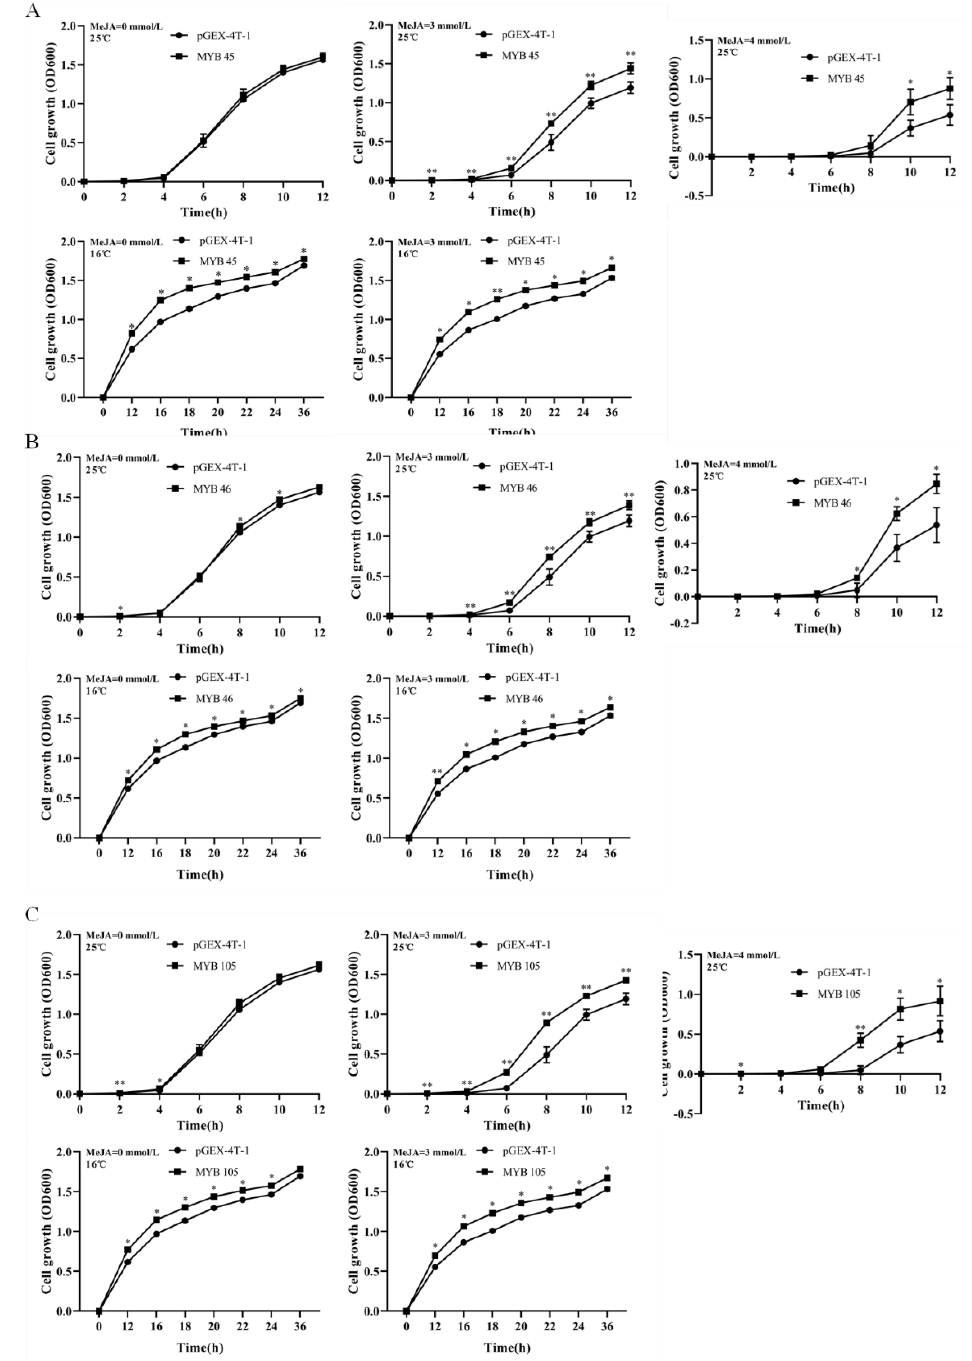
Figure 4. The growth rates of E. coli cells containing the overexpression vectors pGEX-4T-1- CsMYB45 ( A ), pGEX-4T-1- CsMYB46 ( B ), and pGEX-4T-1- CsMYB105 ( C ) under cold stress alone (16 ◦ C), MeJA treatment alone (3 or 4 mM), and the combined treatment. Data are shown as mean ± SD ( n = 3). *, p < 0.05; **, p < 0.01. After 12 h, the pGEXT − 4T − 1 E. coli survival decreased rapidly, but the CsMYB45 − ,